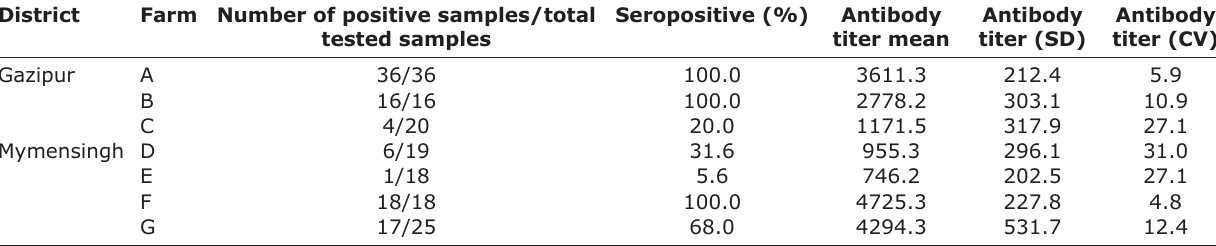
Table-3: Serological detection of ARV in broiler according to farm. District